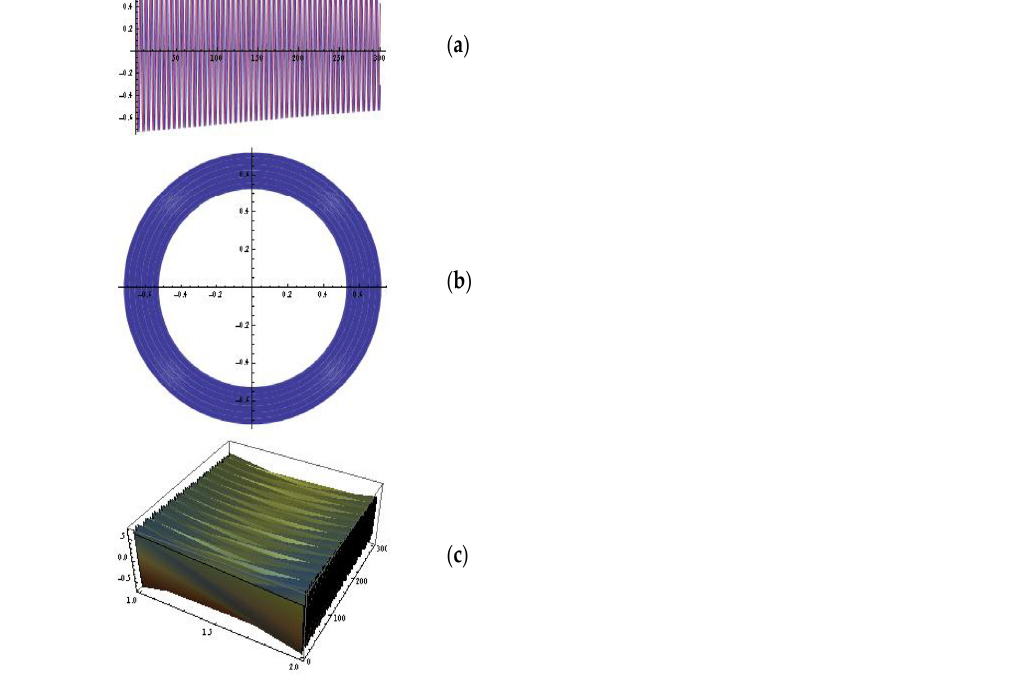
Figure 9. ( a ) The solutions of the system (8) ( (cid:101) = 0.001; n = 7; µ = 7.00805257); ( b ) the portrait ( x , y ) ; ( c ) 3D